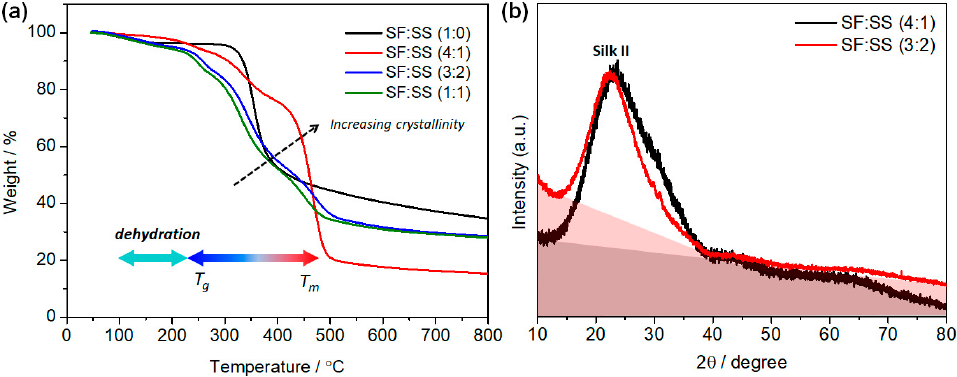
Figure 5. ( a ) TGA curves of various SF:SS composites with different composition. ( b ) X-ray diffrac- tion pattern of SF:SS (4:1) and SF:SS